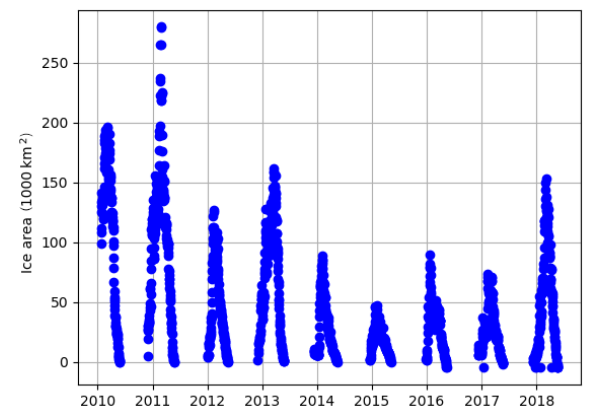
Figure 13. Integrated sea ice area of the Baltic Sea based on Finnish ice